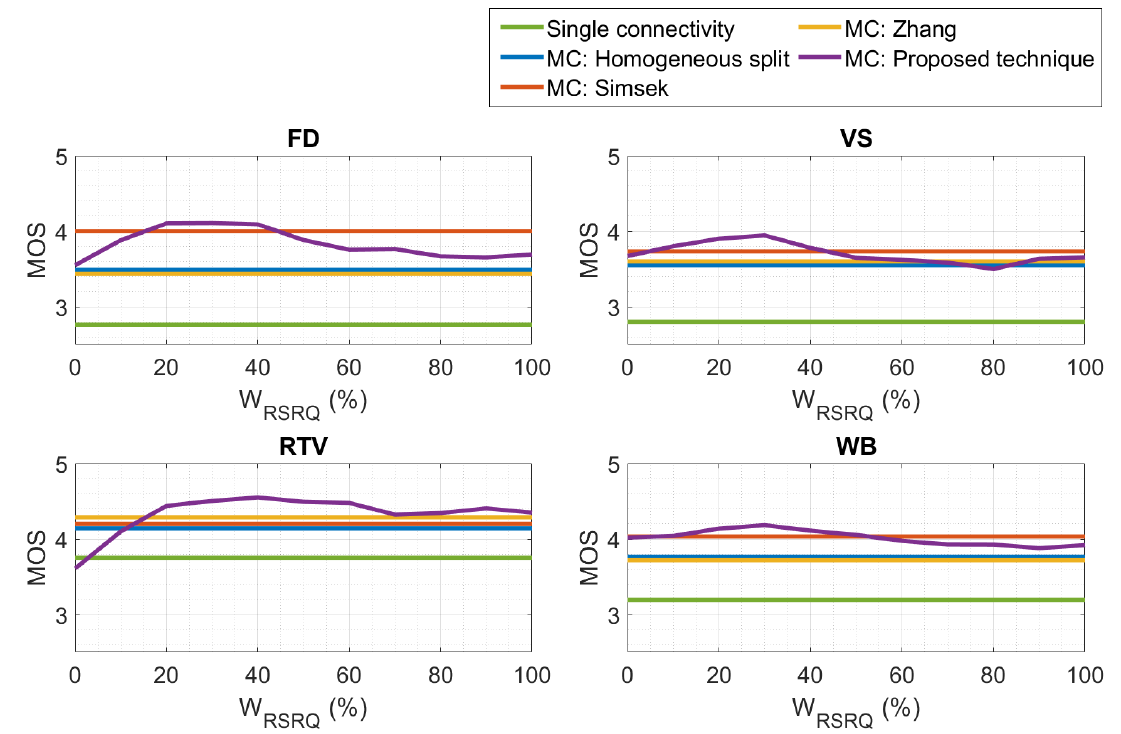
Figure 4. Median of the MOS per UE for each